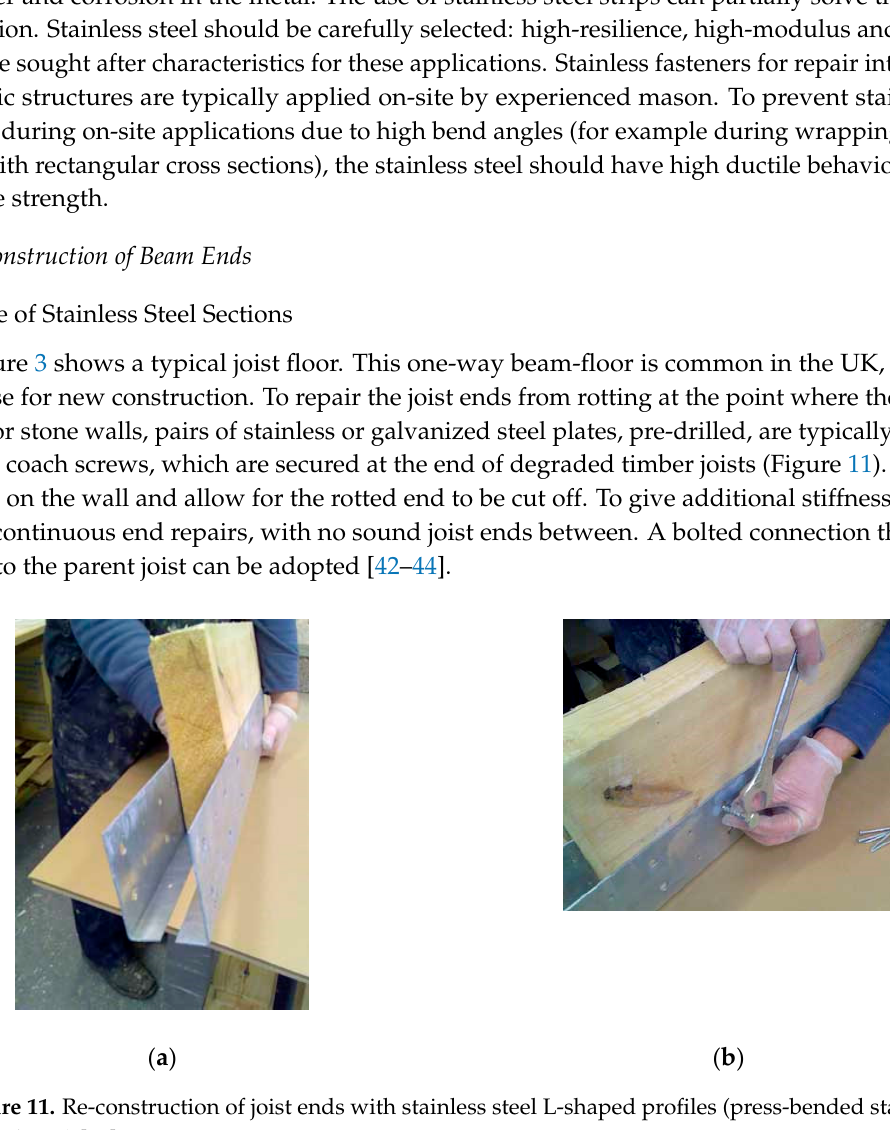
Figure 10. The traditional use of metal fasteners in critical sections of the timber beam floor and the king post roof truss: ( a ) timber template-beam (beam-floor); ( b ) joint king post-tie beam (truss); ( c ) joint strut-king post and principal rafter-king post (truss); ( d ) joint principal rafter-tie beam (truss).